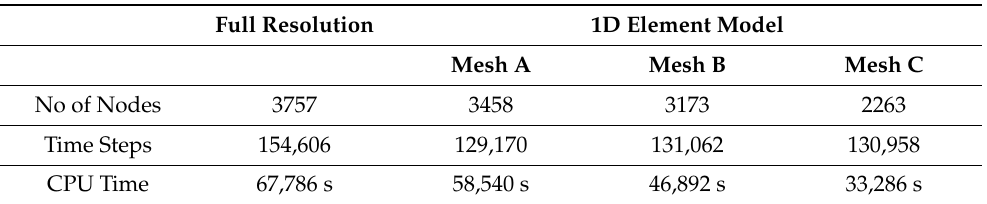
Table 3. Comparison of computational cost of full-resolution and one-dimensional element model simulations of violent slosh test